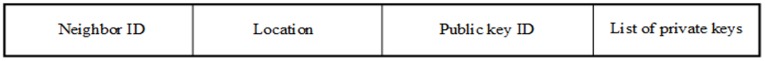
Neighborhood table.